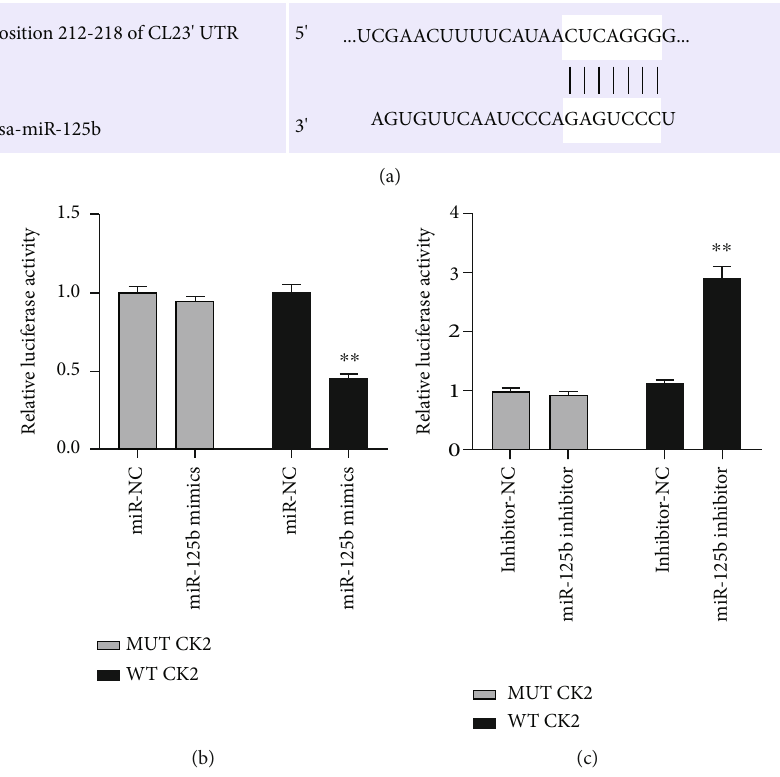
Figure 2: CK2 is a target of miR-125b in MH7A cells. (a) The putative binding site between miR-125b and CK2 was predicted by TargetScan. (b, c) MH7A cells were transfected with miR-125b mimics or miR-NC (b) and miR-125b inhibitor or inhibitor NC (c); then, the relative luciferase activity of WT or MUT CK2 was evaluated by using a dual luciferase reporter system. ∗ p < 0 : 05 , ∗∗ p < 0 : 01 , and ∗∗∗ p < 0 : 001